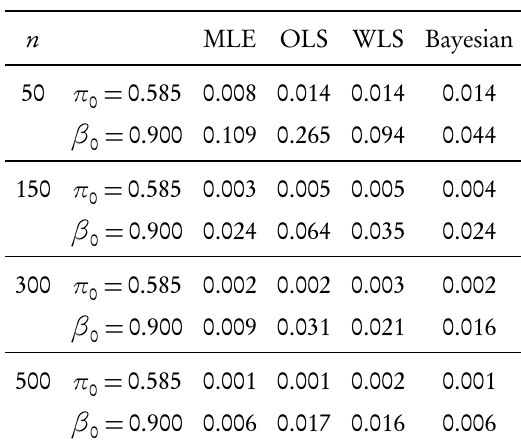
MSEs for combination III